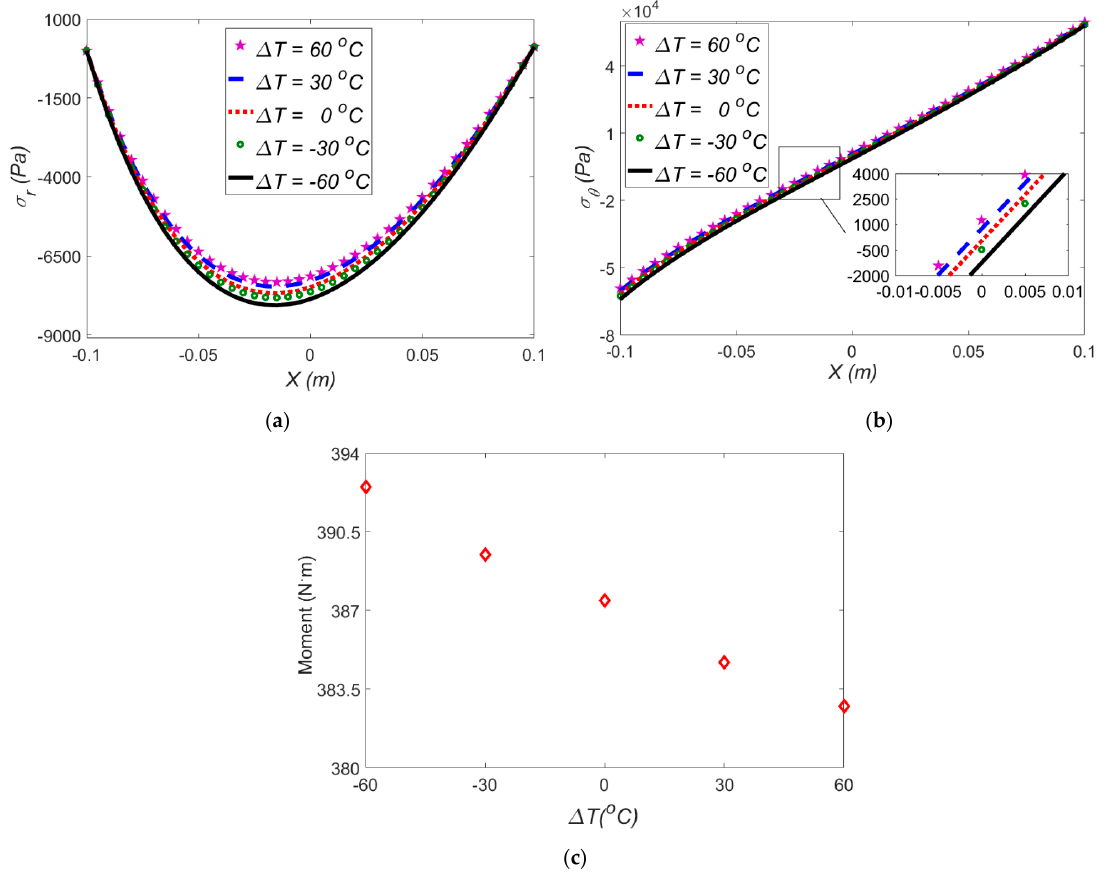
Figure 5. The effect of temperature gradients on ( a ) radial stress; ( b ) hoop stress; ( c ) induced moment for Mooney-Rivlin model in the absence of electric field at ρ = 0.3 m .